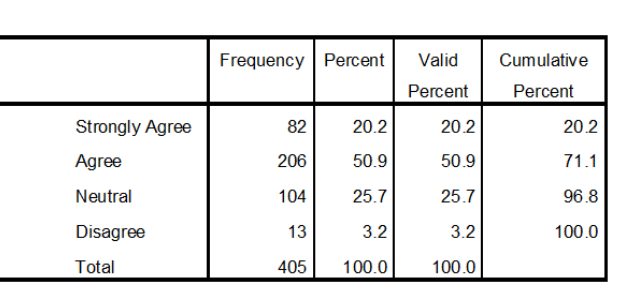
Fig 25. We have mechanisms to ensure quick product development without loss of time